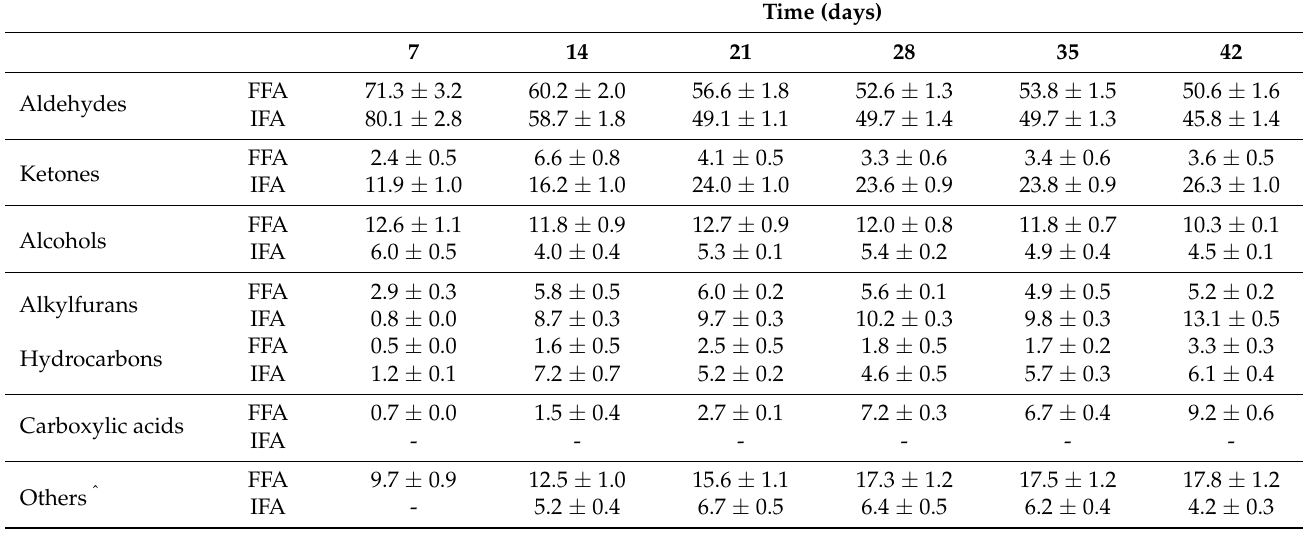
Table 2. Main categories of volatile compounds in FFA and IFA during heating (area percentage, mean value ± SD). Time